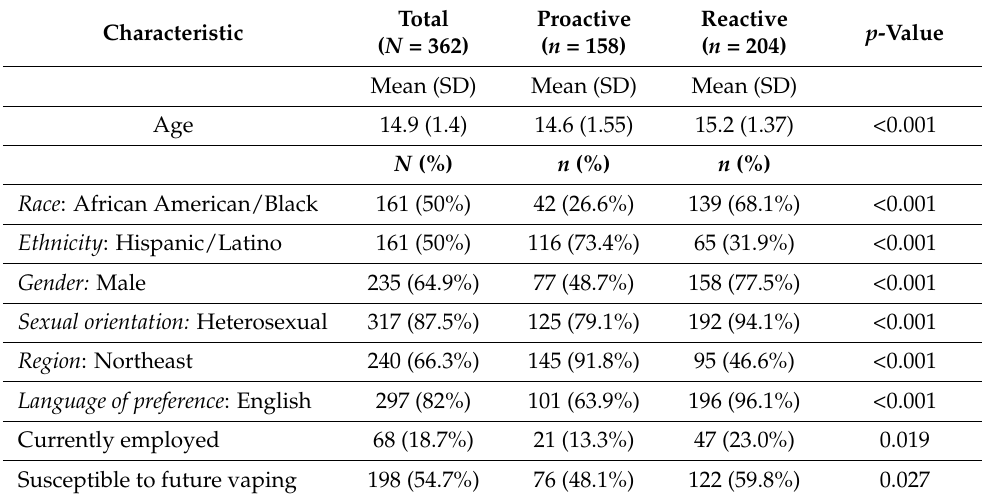
Table 3. Baseline characteristics of enrolled participants who were recruited using proactive and reactive